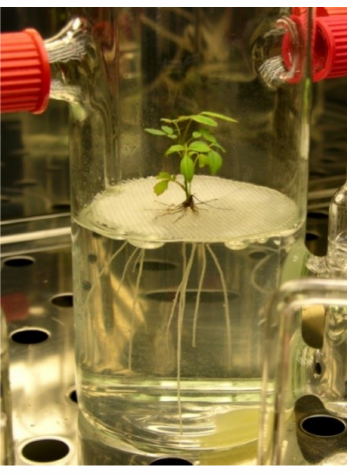
Figure 4. Rose plant ( Rosa canina L.) growing in sterile hydroponics in 0.5 × Murashige–Skoog medium supplemented with 2% sucrose in a bioreactor operated in airlift